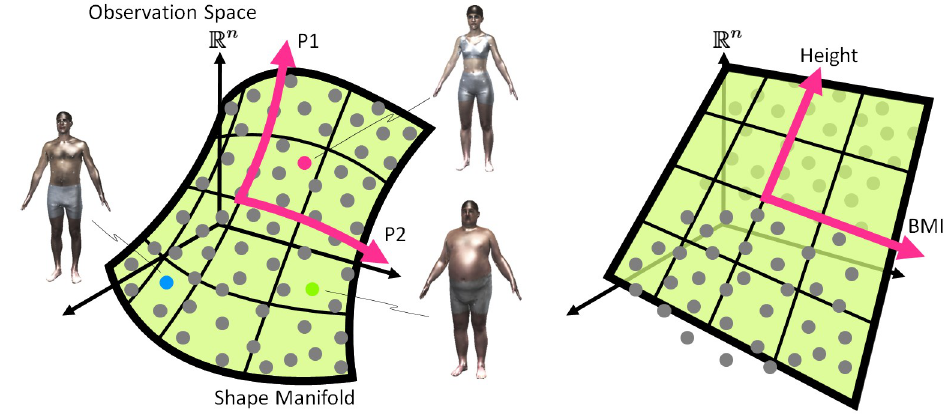
Fig 5. Graphical illustration of ( P 1 , P 2 ) and the classical